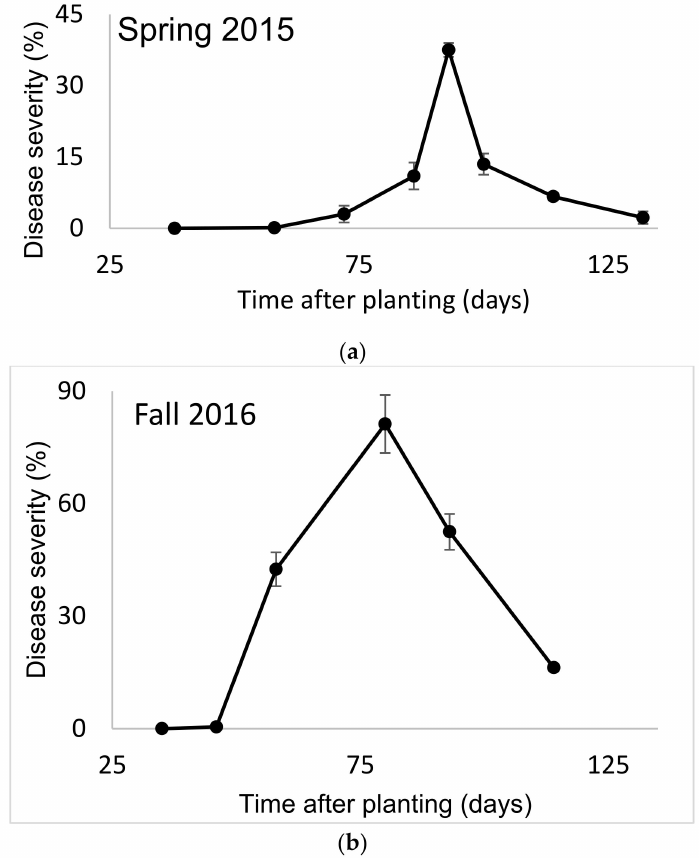
Figure 1. Development of sweet basil downy mildew (SBDM) during ( a ) a spring growing season and ( b ) an autumn growing season. SBDM severity was evaluated on a scale of 0–100%, in which 0 = healthy plants and 100% = plants completely covered with SBDM symptoms/signs. Bar = SE; n =